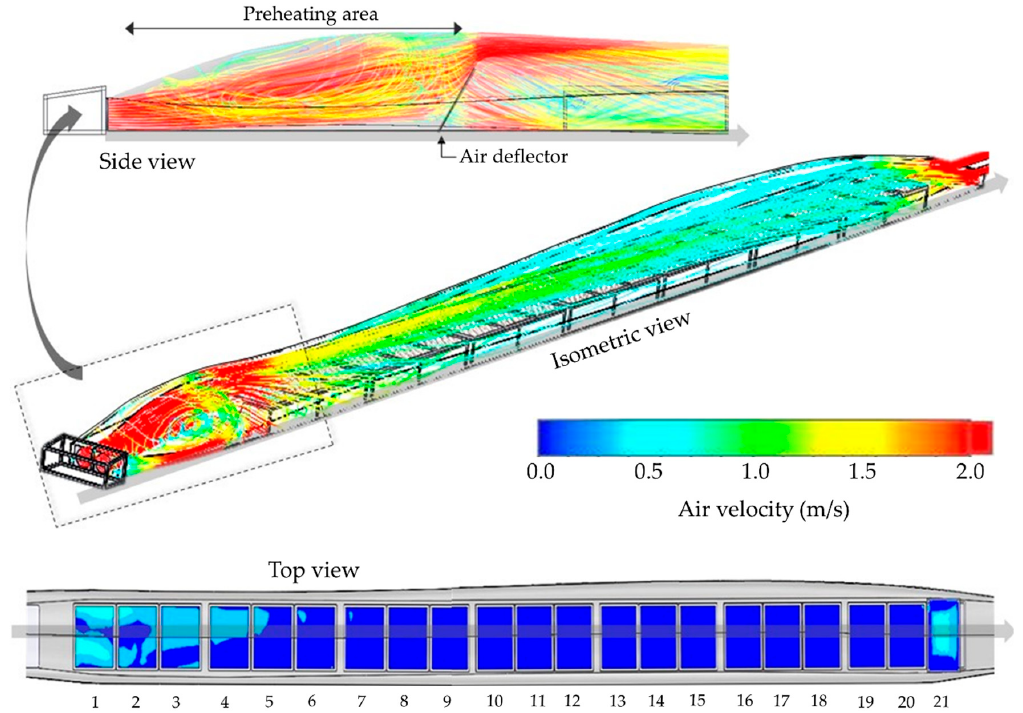
Figure 4. Visualization of airflow distribution and direction in the ISD (isometric and side view) and vertical flow through the 21 trays (top view).